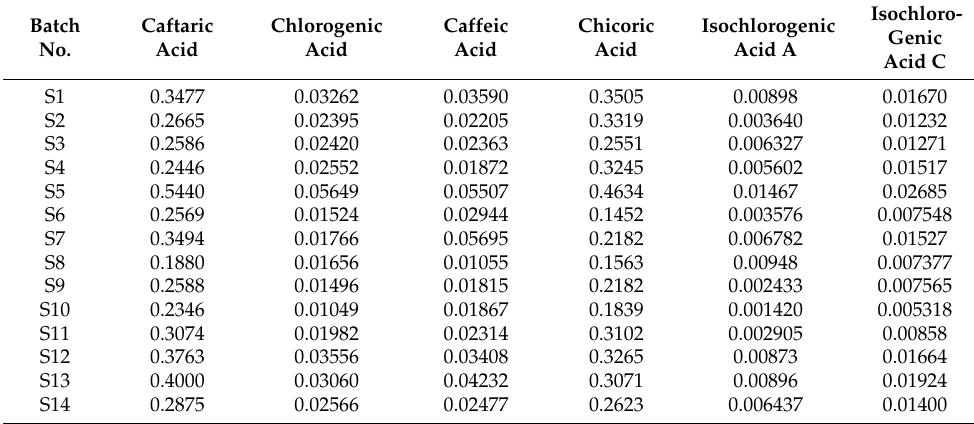
Table 11. The content of 6 ingredients in the 19 batches of dandelion water extract (%). Batch